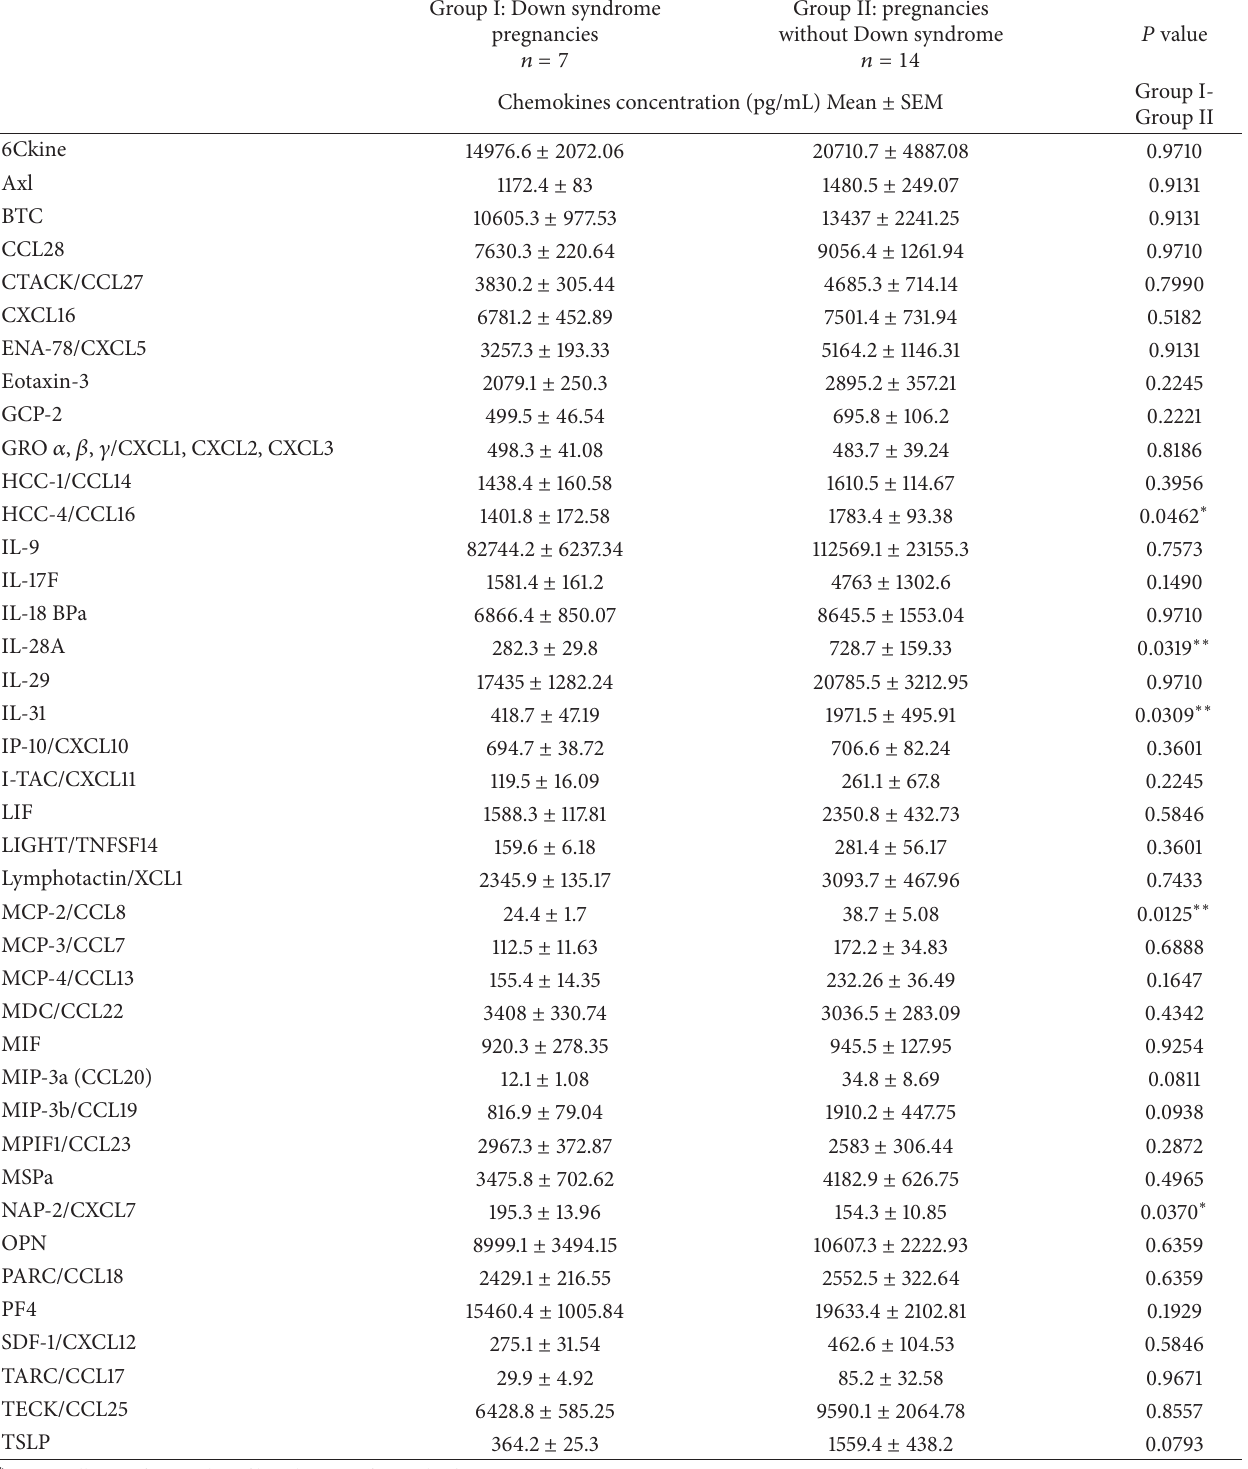
Table 2: Concentrations of chemokines in maternal